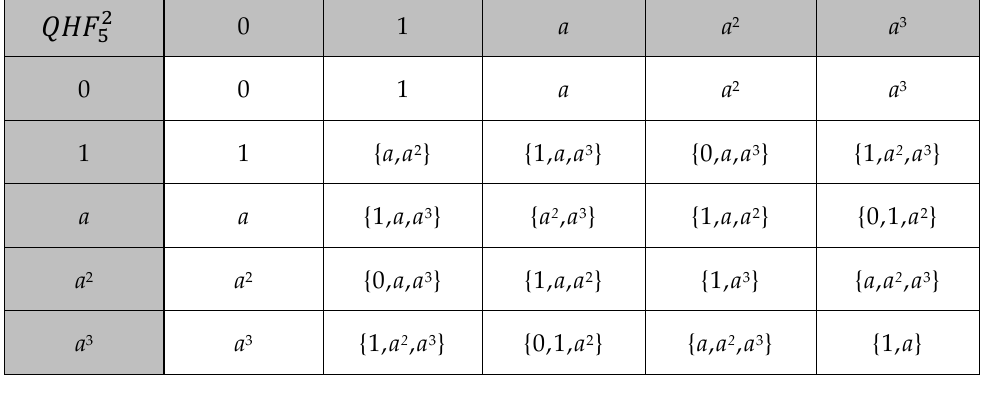
Table 15. The Cayley tables of the additive canonical hypergroup of the hyperfield ℤ 13 / G, which is also denoted by 𝑄𝐻𝐹 52 and of its augmented hyperfield [ ℤ 13 / G ], which is also denoted by 𝑄𝐻𝐹 53